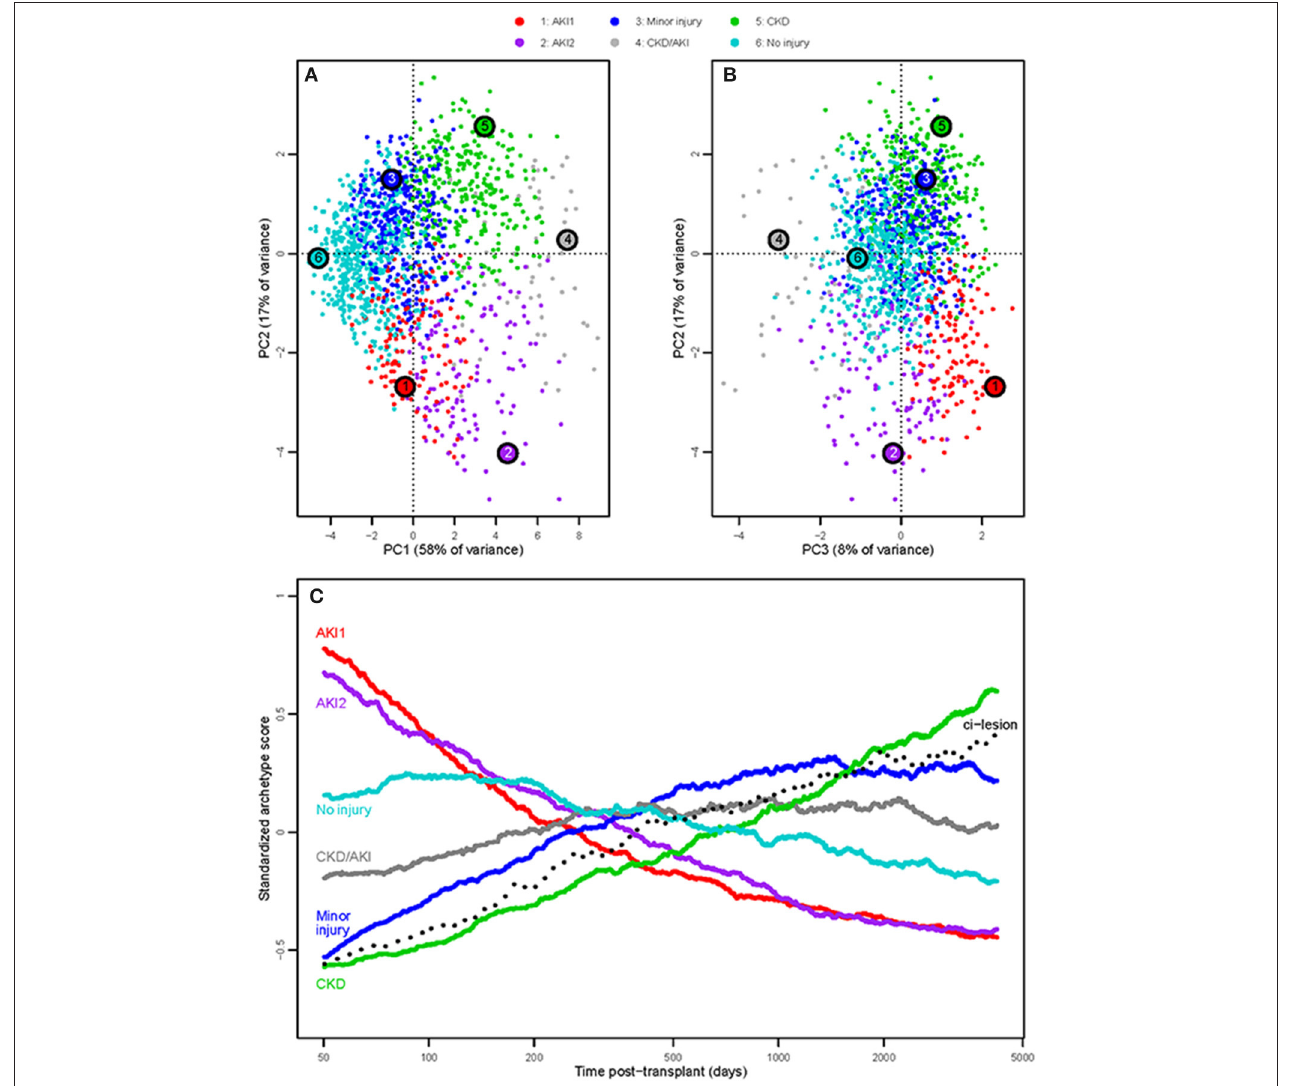
FIGURE 1 | Injury-based PCA, colored by injury archetype cluster. (A) PC2 vs. PC1 scores for each biopsy; (B) PC2 vs. PC3 scores; (C) moving averages of standardized injury archetype scores (window size = 400 biopsies). As there are large differences in mean scores between archetypes, all scores were standardized to a mean of 0.0 before plotting. The y-axis is in standard deviation units. Biopsies sorted by ascending time of biopsy